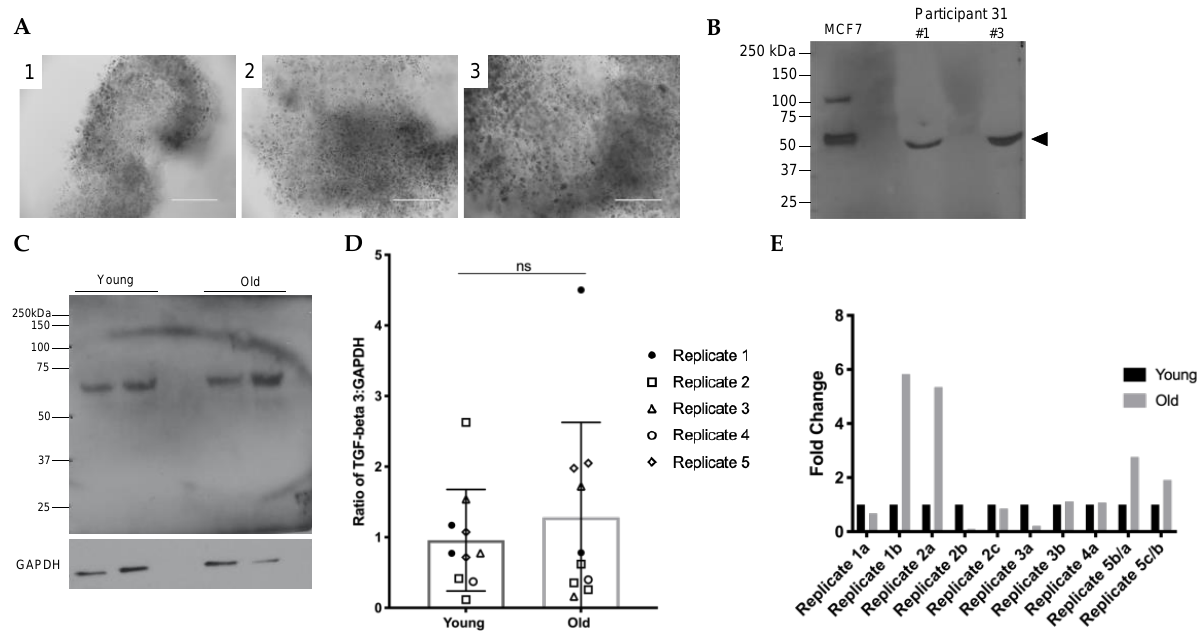
Figure 4. Specific detection of TGF β 3 in human cumulus cells shows no significant difference with age. ( A ) Three representative images of the varying sizes of cumulus cell masses from smaller to larger are shown from participant 42 (39 y). All cumulus cell images were taken upon receipt to the lab. ( B ) We observed a specific immunoreactive band for TGF β 3 at 50 kDa representing the pro-form of the TGF β 3 molecule. MCF7 is the positive control. Two intact cumulus cell masses from participant 31 are shown in lanes 2 and 3. The arrow indicates TGF β 3 (50 kDa). ( C ) Representative blot probed with antibodies recognizing TGF β 3 and reprobed for GAPDH (36 kDa). ( D ) Ratio of TGF β 3 to GAPDH in young and old cumulus cells for all replicates. Young and old groups N.S. ( E ) Fold-change of TGF β 3 in old cumulus cells compared to young cumulus cells for all replicates. More detailed information about each participant can be found in Supplementary Table S1. Scale bar = 100 µm. Table 3. Young vs. old participant cumulus cell information.